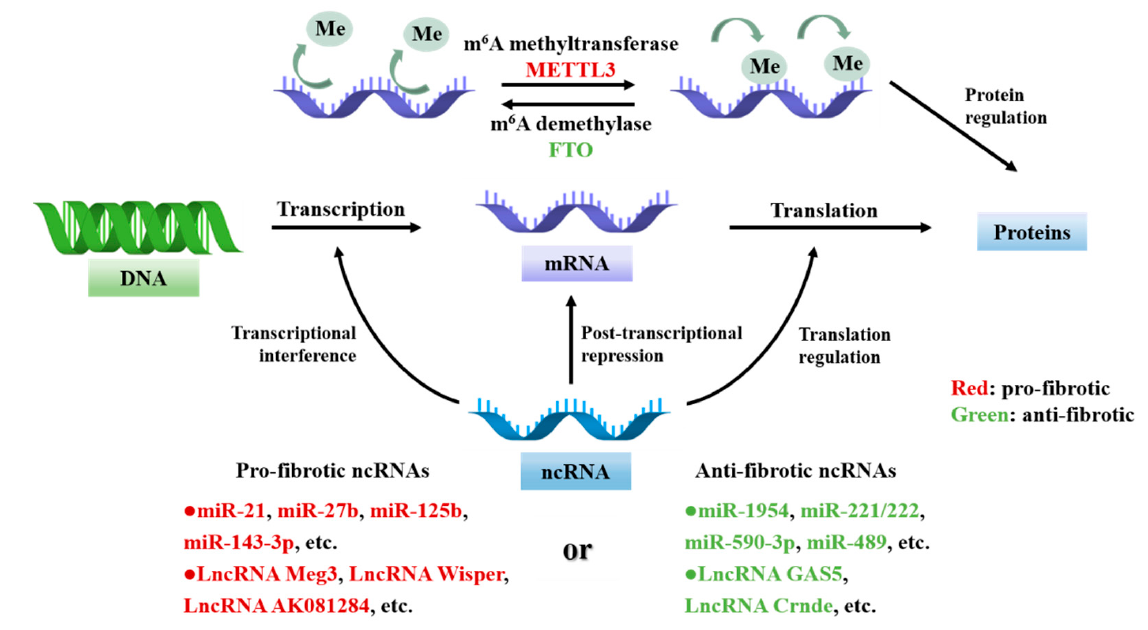
Figure 5. RNA regulates transcriptional and translational processes through multi-level ncRNA and RNA modifications involved in CFs activation and cardiac fibrosis. Multi-level of ncRNAs (e.g., miRNAs and lncRNAs) play cardiac pro-fibrotic and anti-fibrotic roles. In addition, m 6 A affects the expression of fiber-associated proteins by regulating the level of mRNA methylation. m 6 A modification process is dynamically reversible and co-regulated by METTL3 and FTO in CFs. As shown in the figure, different colors suggest that different ncRNA and epigenetic-modifying enzymes play different roles in cardiac fibrosis.